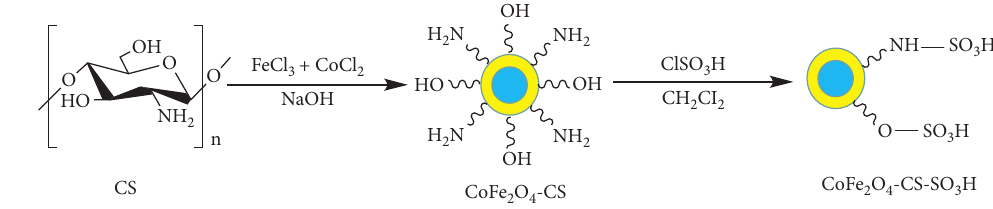
Figure 1: The preparation process of CoFe